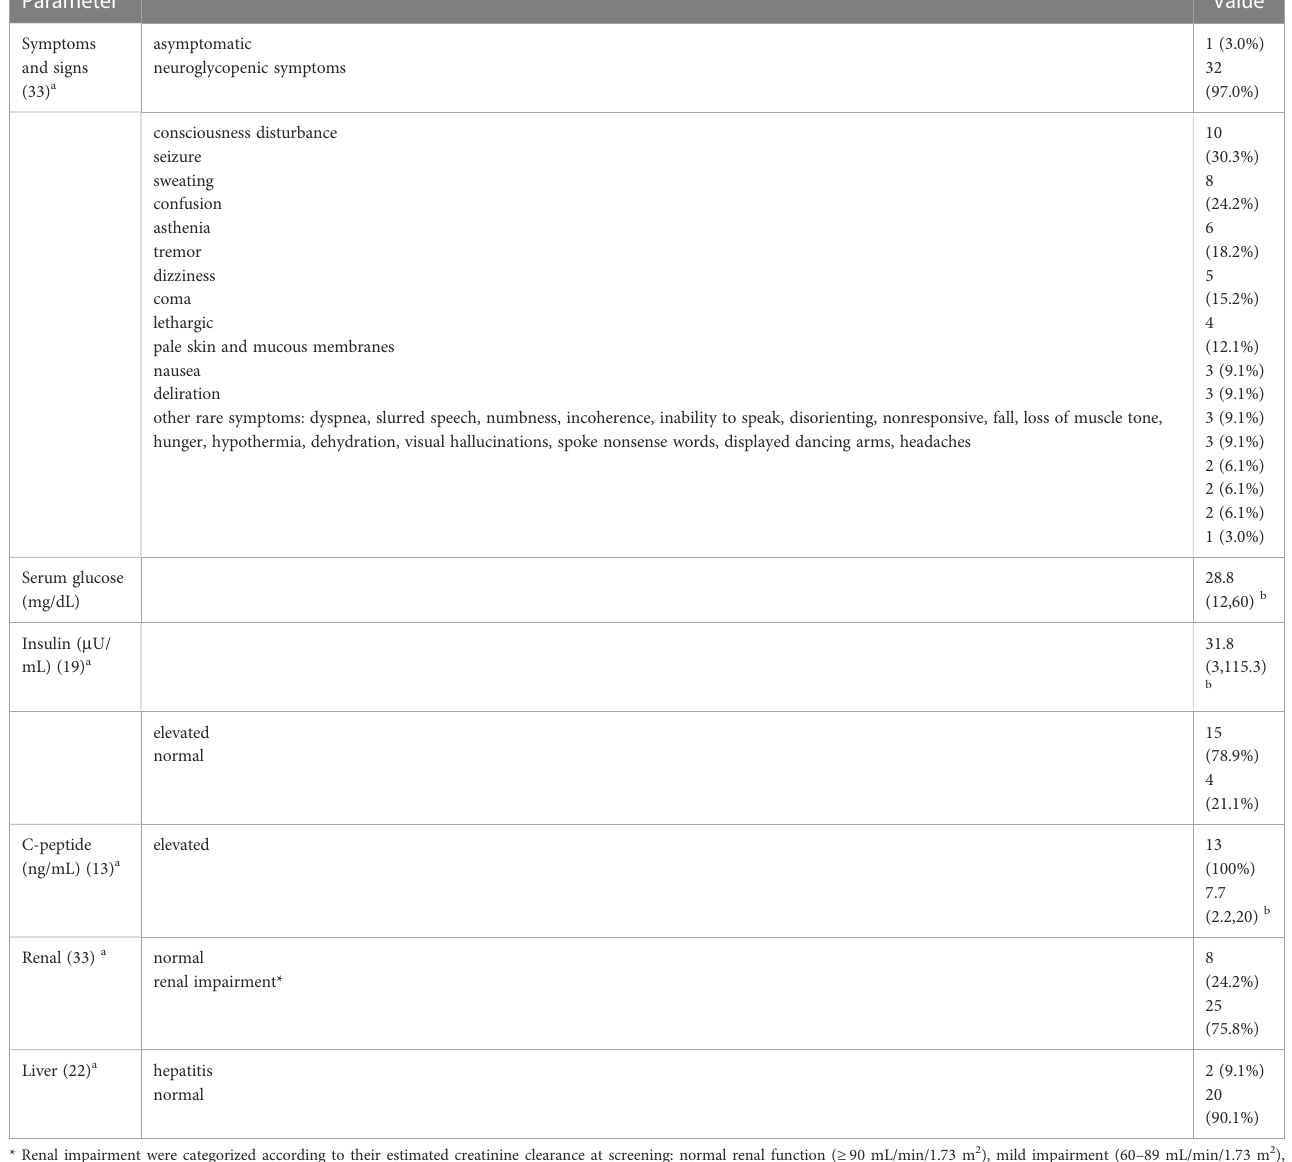
TABLE 3 Summary of clinical symptoms and laboratory tests of 34 patients.